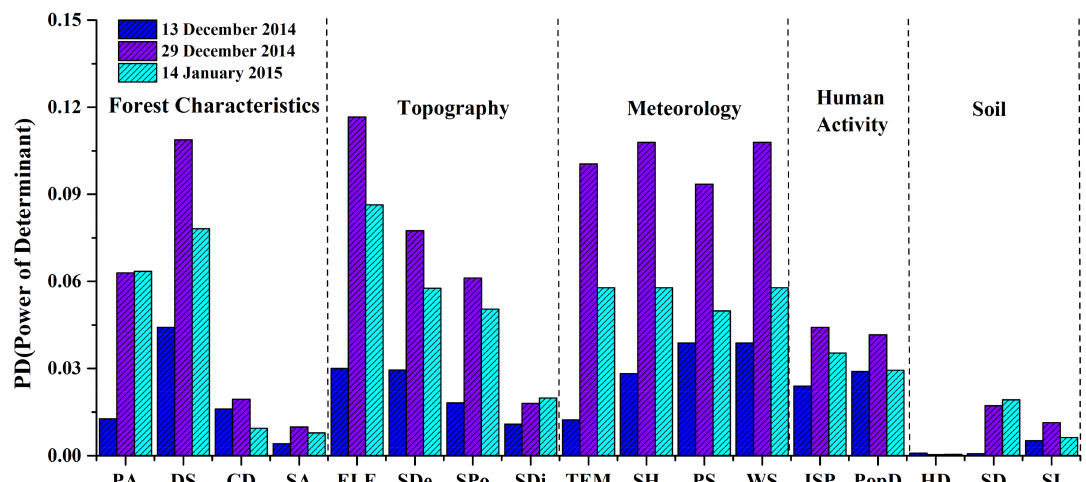
Figure 4. The power of determinants of different impact factors (forest, soils, topography, meteorological factors, and population) on PM 2.5 concentrations in Jinjiang. (PA = patch area, DS = dominant species, CD = canopy density, SA = stand age, SI = site index, SD = soil depth, HD = humus depth, ELE = elevation, SDe = degree of slope, SPo = slope of position, SDi = slope aspect, PopD = population density, ISP = impervious surface percentage, TEM = temperature, SH = specific humidity, PS = pressure, WS = wind speed), p -values < 0.1 for all factors.